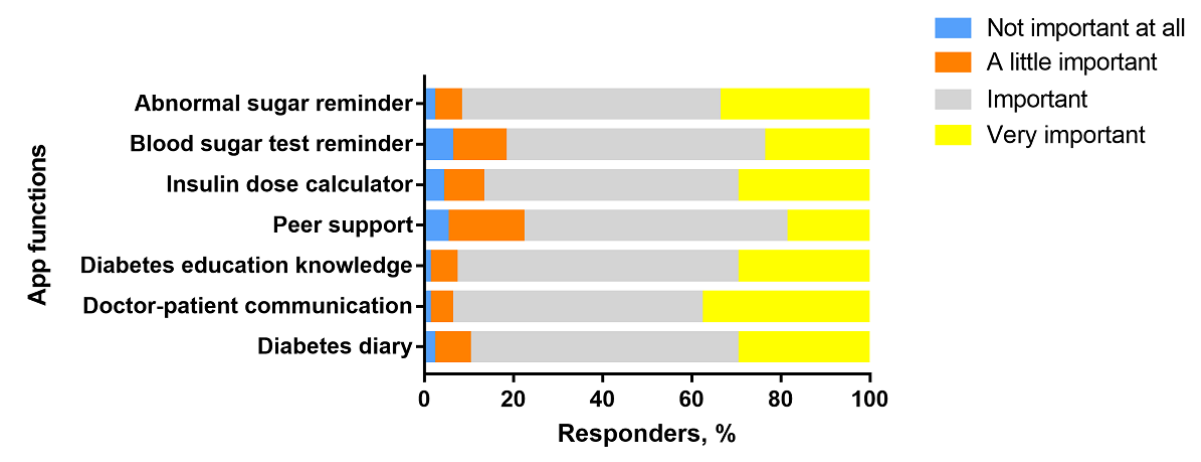
Figure 2. Importance of different app functions reported by patients with diabetes (N=1276).